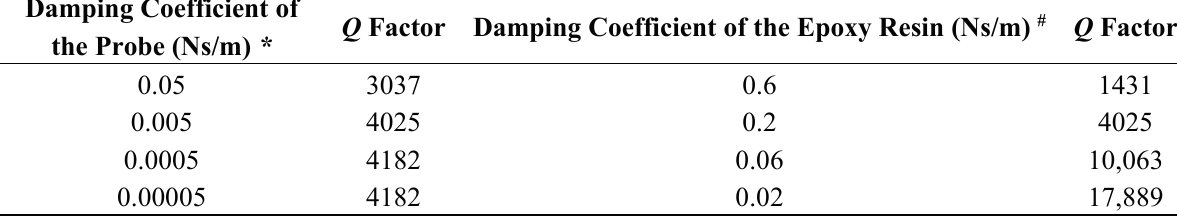
Table 4. The impact of the damping coefficient on the Q factor.